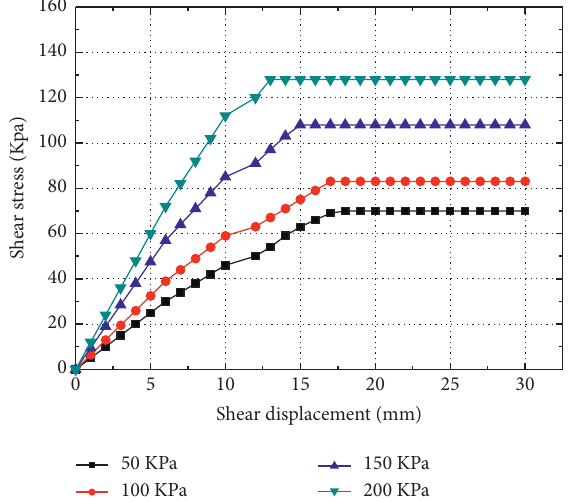
Figure 6: Shear numerical test